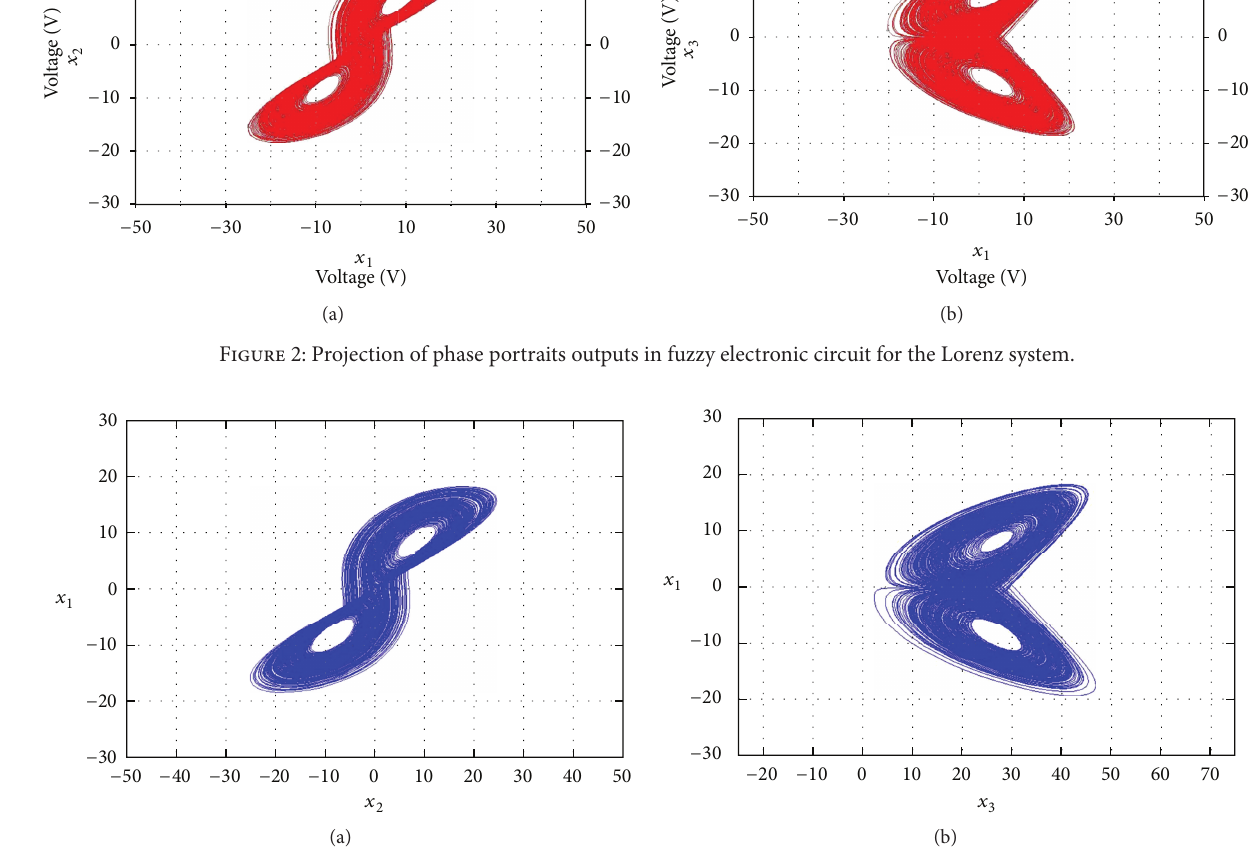
Figure 3: Projection of phase portraits in MATLAB for fuzzy chaotic Lorenz